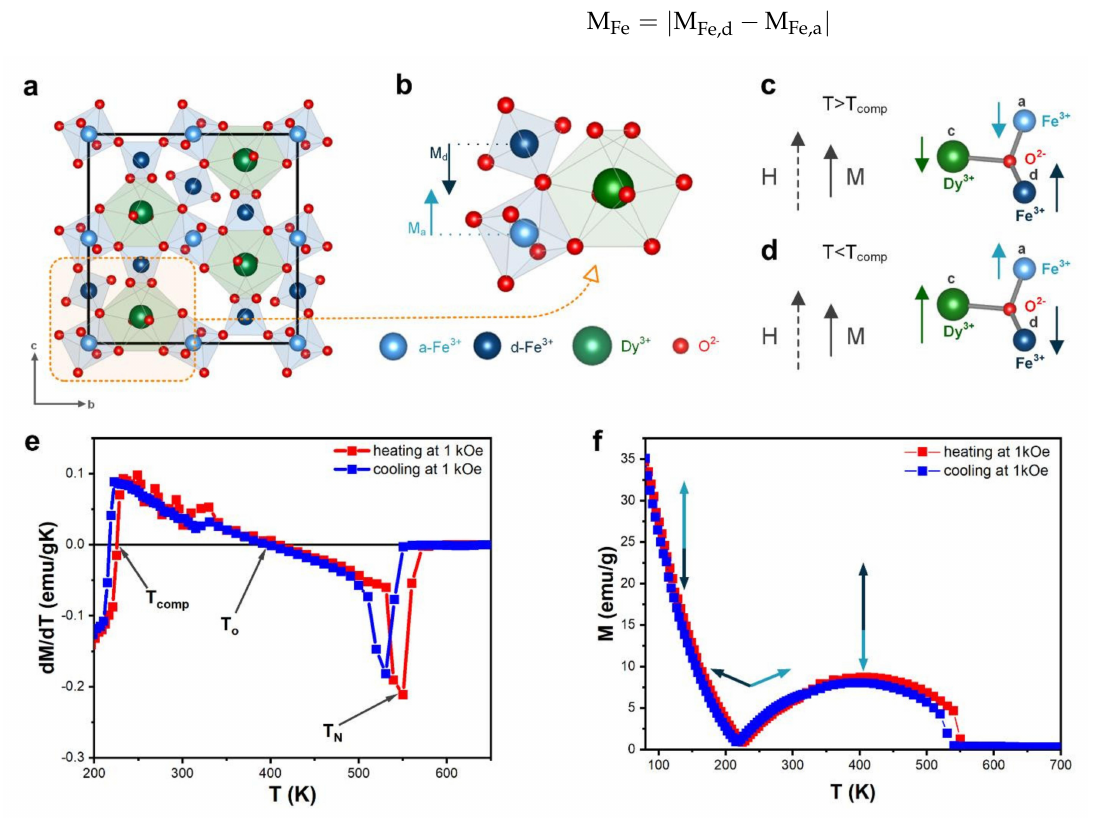
Figure 4. ( a ) The crystal structure of DyIG; ( b ) Unit cell of DyIG; ( c ) Magnetic moments below compensation temperature; ( d ) Magnetic moments above compensation temperature; ( e ) Temper- ature dependent magnetization at 0.1 T for DyIG; ( f ) Derivative of the temperature-dependence magnetization at 1 kOe was used for determination of characteristic temperatures.